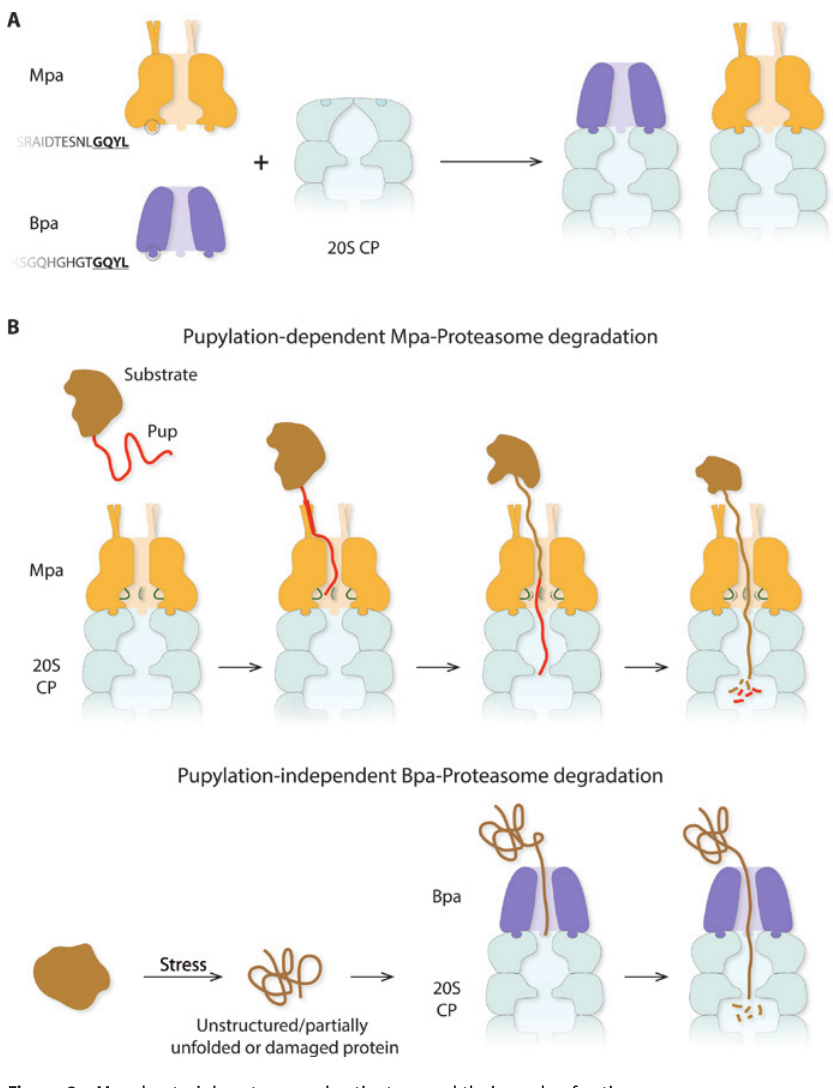
Figure 2: Mycobacterial proteasomal activators and their mode of action. (A) The energy-dependent Mpa and energy-independent Bpa complexes interact with the 20S core particle by docking into binding pockets of the core particle using a shared C-terminal GQYL motif. (B) The ATPase Mpa recognizes pupylated substrates (brown) by binding